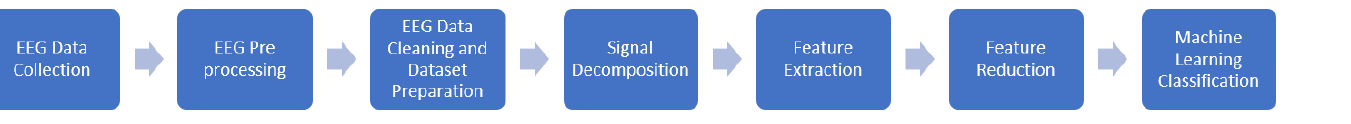
Figure 2. The process of epileptic seizure data classification.